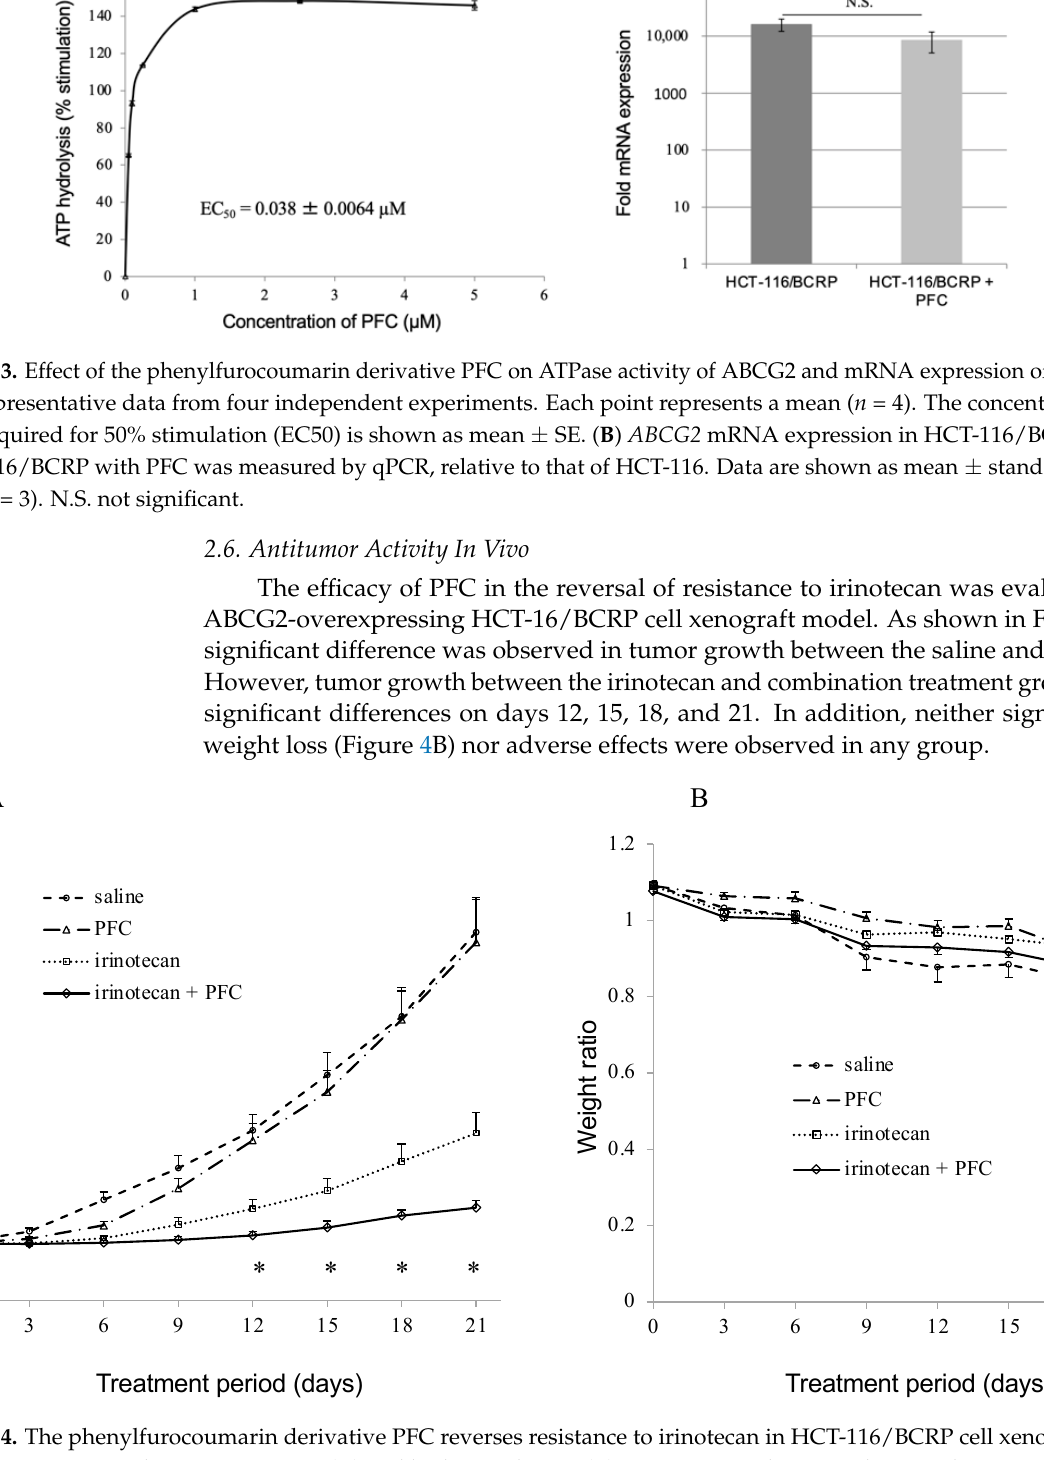
Figure 4. The phenylfurocoumarin derivative PFC reverses resistance to irinotecan in HCT-116/BCRP cell xenografts in nude mice. Tumor volume increase rate ( A ) and body weight rate ( B ) were measured every 3 days. Each point represents a mean ( n = 5). Bars show standard error (SE). p values were determined with the two-tailed Student’s t -test (* p < 0.05: irinotecan versus irinotecan + PFC).